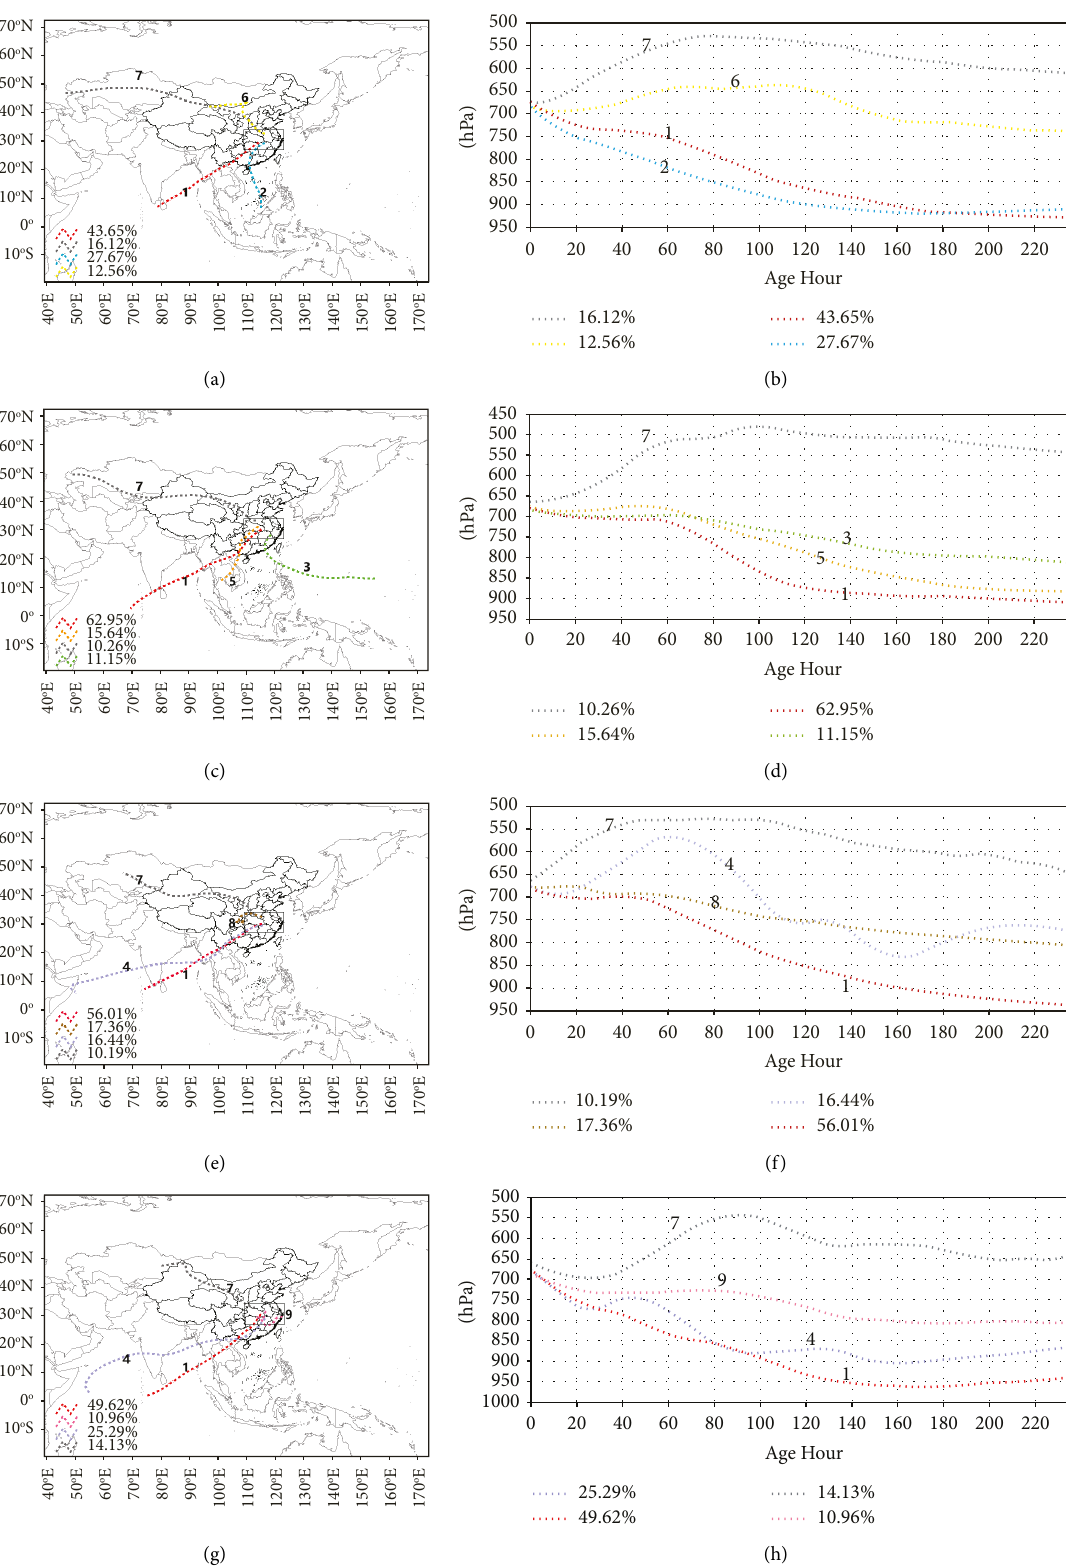
Figure 7: The spatial distribution of middle-level water vapor channels (a, c, e, g) and their height evolution (b, d, f, h) ((a, b) for SFP, (c, d) for SHEP, (e, f) for NCVP, and (g, h) for